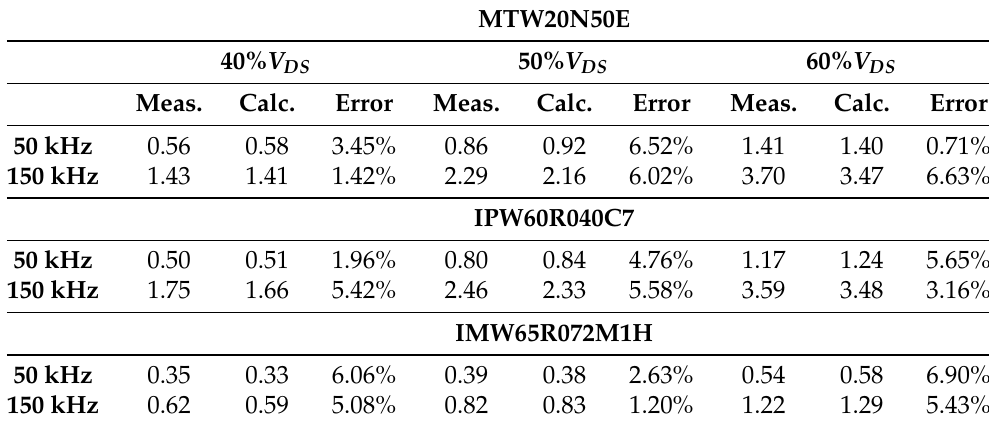
Table 1. Comparison among measured and calculated losses.